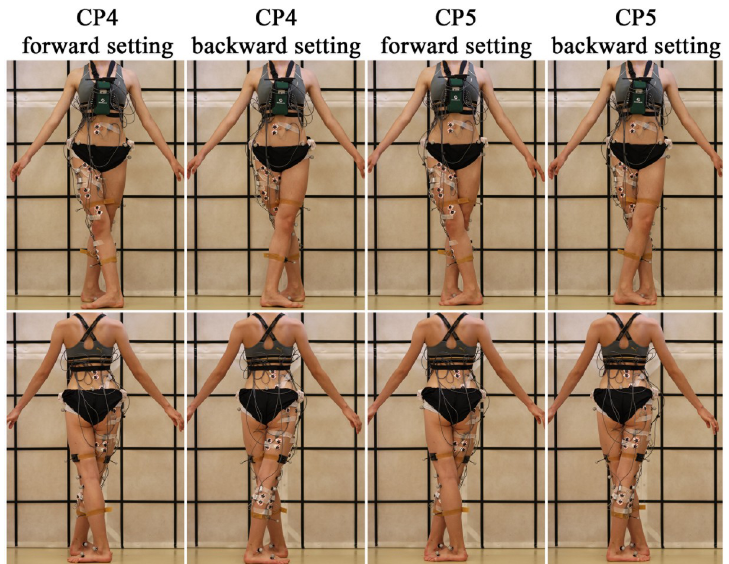
Fig 3. Presentation of classical ballet positions and electrode placement. Fourth classical ballet position (CP4) with forward setting: both feet are turned in opposite directions, right foot is in front with heel at the level of the middle of the left foot with a one-foot distance in anterior-posterior direction between the feet. Fourth classical ballet position (CP4) with backward setting: position is the same as previous but the left foot is in front. Fifth classical ballet position (CP5) with forward setting: both feet are turned in opposite directions, right foot is in front toes of each foot touch the heel of the other. Fifth classical ballet position (CP5) with backward setting: position is the same as previous but the left foot is in